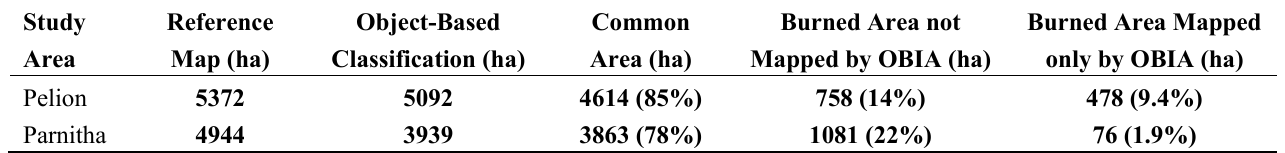
Table 5. Sizes of the burned areas and results of the spatial overlays between the reference map and the object-based classification result for the study areas of Pelion and